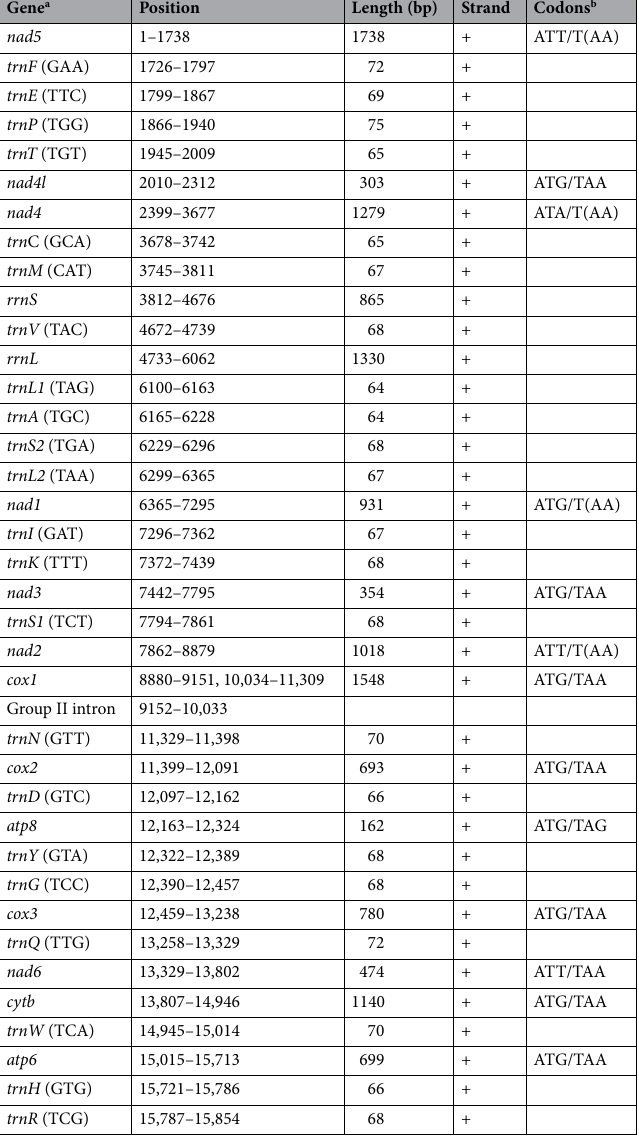
Table 1. Summary of the nearly complete mitochondrial genome of Travisia sanrikuensis (15,854 bp). a Anticodons of tRNA are shown in parentheses. b Incomplete stop codons are shown in